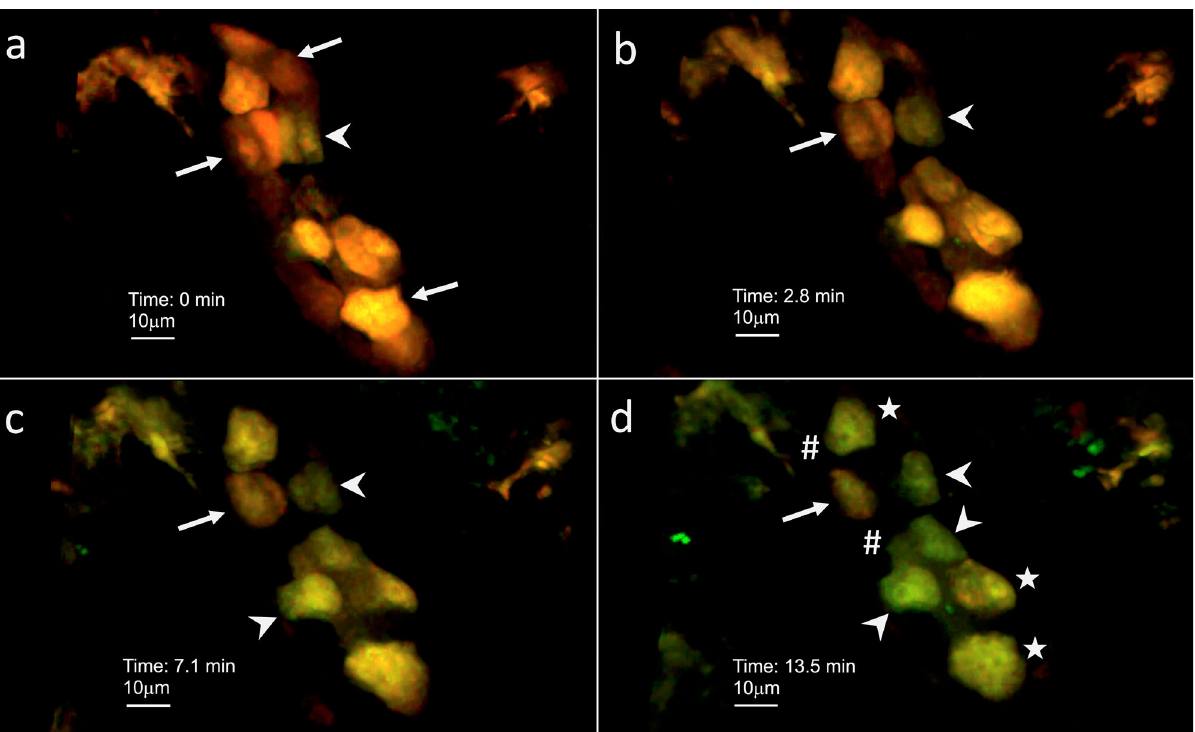
Fig. 8 Murine ICs internalize and acidify E. coli . An “ IC reporter ” kidney tubule with tdT-expressing ICs (red) was perfused with pHrodo Green E. coli - coated BioParticles for phagocytosis that fl uoresce green when acidi fi ed. a At the 0 min time point red ICs are seen (arrow). Because the 0 min time point started ~1 min after injection when we identi fi ed our target tubule and narrowed the focus, some cells may be already starting to uptake bioparticles (arrowhead). b Increasing green fl uorescence occurs in patchy areas in the cytoplasm in an isolated IC (arrow) as the experiment progresses to the 2.8 min time point but not some remain red (arrow). c At the 7.1 min time point, most ICs are increasingly green (arrowheads), but an isolated IC remains red (arrow). d At the 13.5 min time point, variable uptake/acidi fi cation can be seen with relatively high (arrowhead), medium (star), or low (arrow) green fl uorescence visualized. No appreciable green fl uorescence is present in red fl uorescence-negative cells (presumed PCs) (pound symbol) within the tubule. a – d Magni fi cation 20×, with digital zoom. Images representative from imaging of three tubules from two mice. Each image is from the same tubule